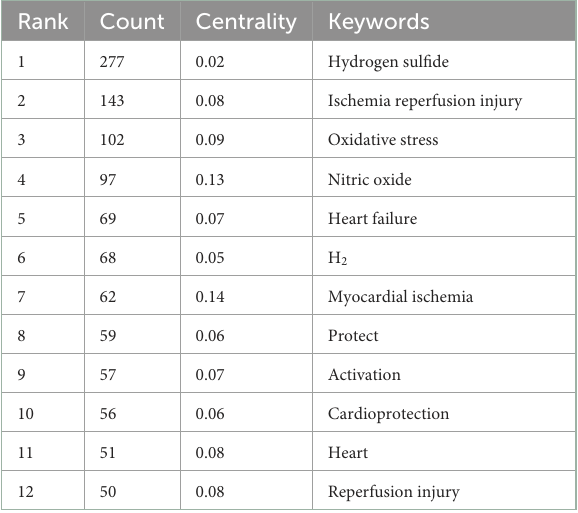
TABLE 5 Top 12 keywords in hydrogen sulfide in heart preservation